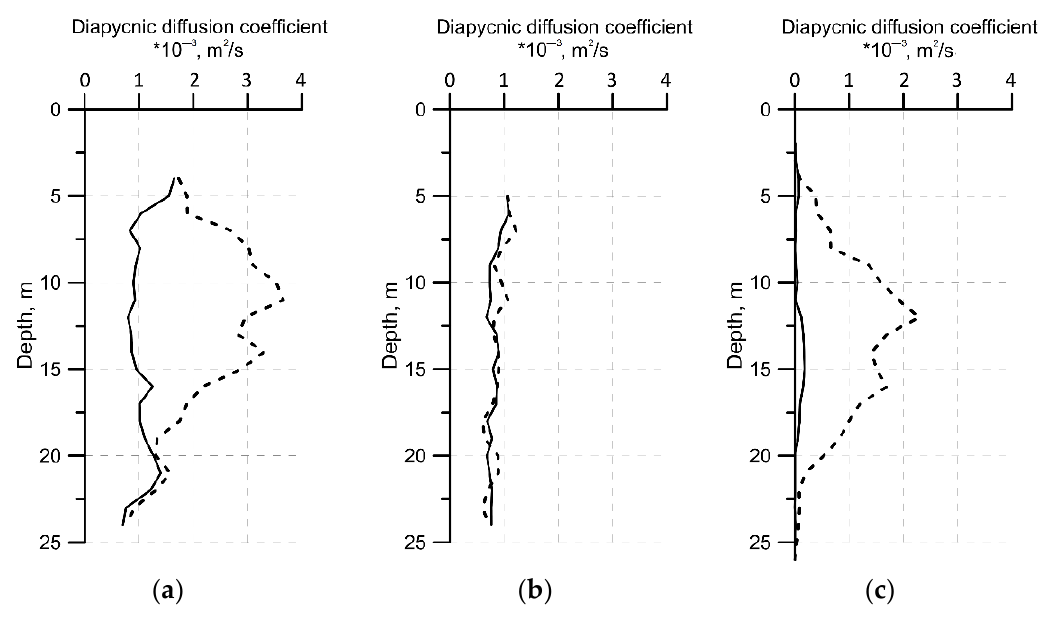
Figure 16. Vertical profiles of the diapycnic diffusion coefficient 𝐾 𝑧 averaged during the tidal cycle from measurements made: ( a ) at polygon 1 in summer, 2011; ( b ) at polygon 4 in summer, 2012; ( c ) at polygon 7 in summer, 2012. Solid (dashed) lines show calculations made with a 2 h (2 min) time step. Table 3. Averaged 𝐾 𝑧 estimates at different polygons supplemented with statistics of ISW obser- vations in summer 2009 – 2014.